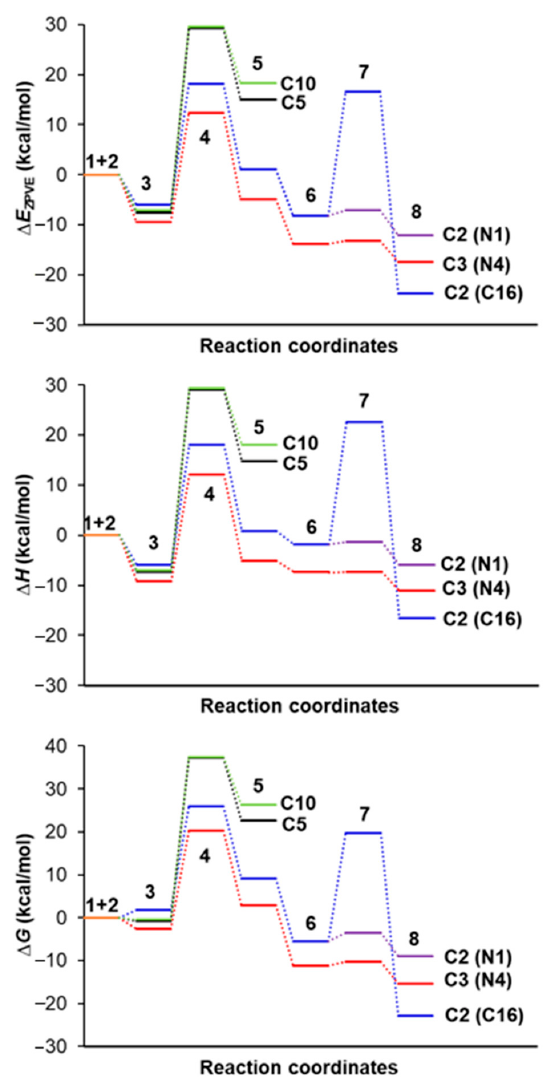
Figure 2. Reaction energy profiles computed for the indicated substitution sites, starting from re‑ actants ( 1 + 2 ), then the nucleophilic addition step with a transition state (TS) 4 and intermediate 5 , spontaneous adduct formation between 5 and the H 2 O molecule ( 6 ), and the hydrolysis step with TS 7 and product ( 8 ). An alternative reaction pathway for the carbon (C2) substitution site is marked as C2 (C16).